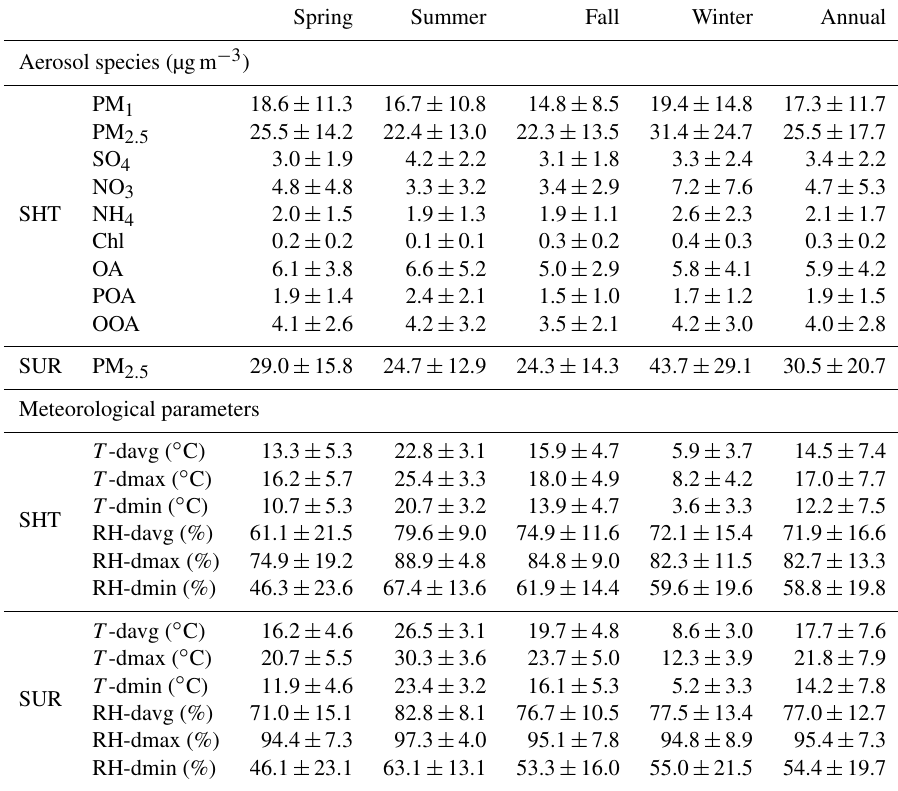
Table 1. The seasonal and annual averaged concentrations of aerosol species (µgm − 3 ) and meteorological parameters. The davg, dmax, and dmin mean the daily average, maximum, and